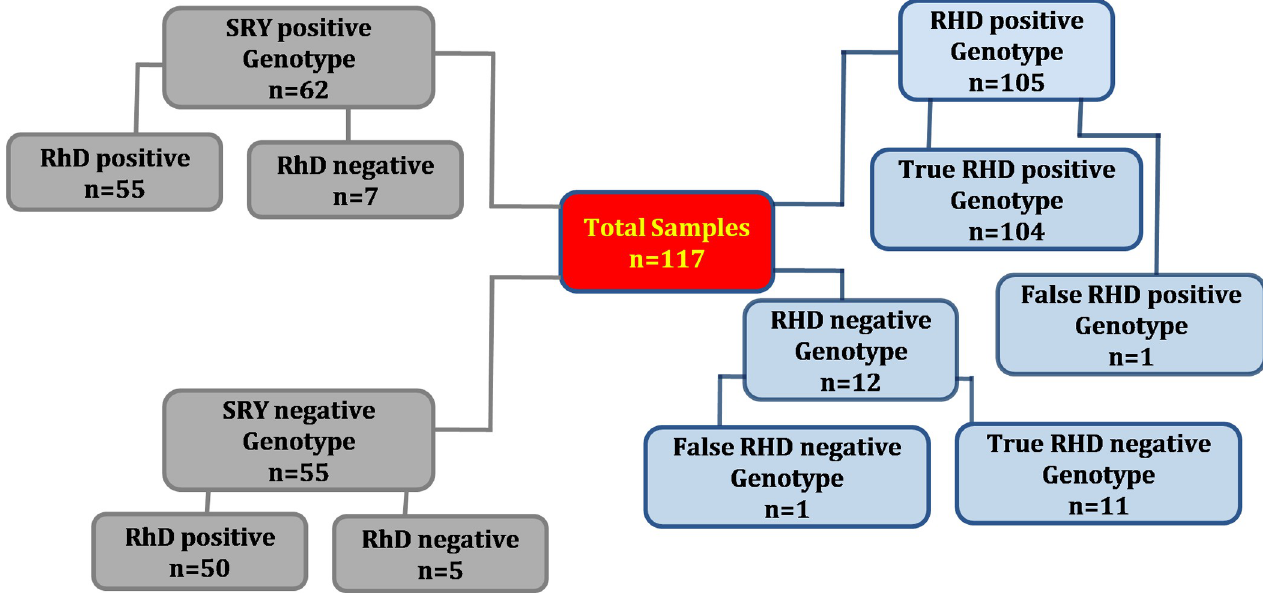
Fig 1. Summary of the results of non-invasive fetal RHD genotyping in maternal plasma.